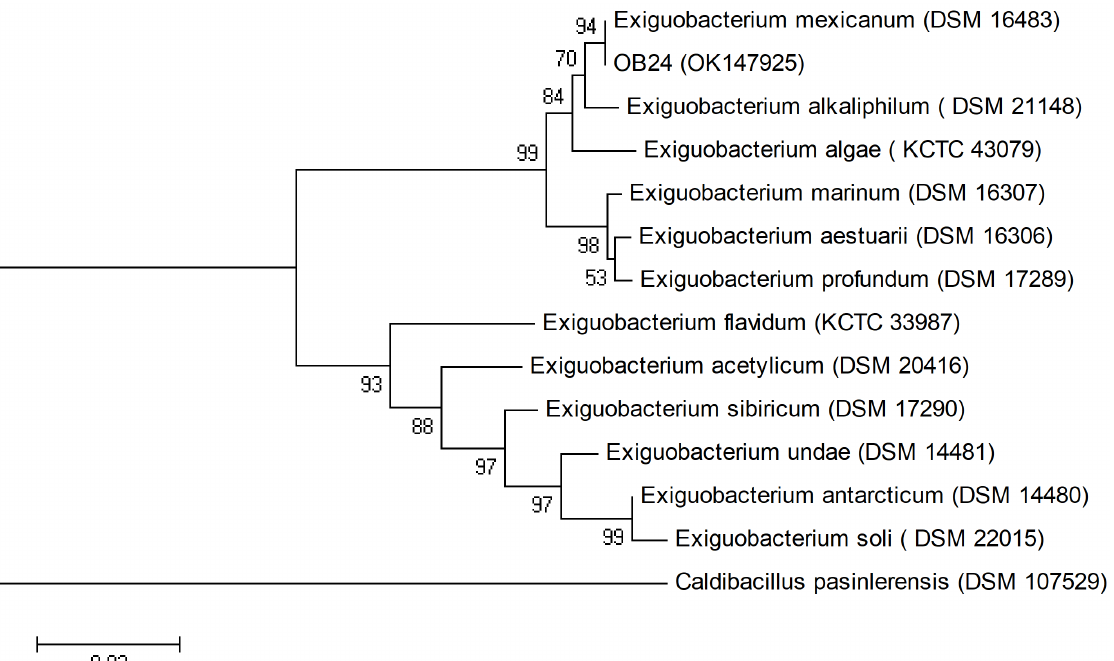
Figure 3. Neighbor joining phylogenetic tree on the basis of 16S rRNA gene sequence data of the Exiguobacterium mexicanum OB24 isolated from rumen samples. Caldibacillus pasinlerensis (Baltaci et al. 2020a) was used as out- group. Bootstrap values based on 1000 replications are listed as percentages at branching points. The accession numbers are given in parentheses. Only bootstrap values >50% are shown at nodes.